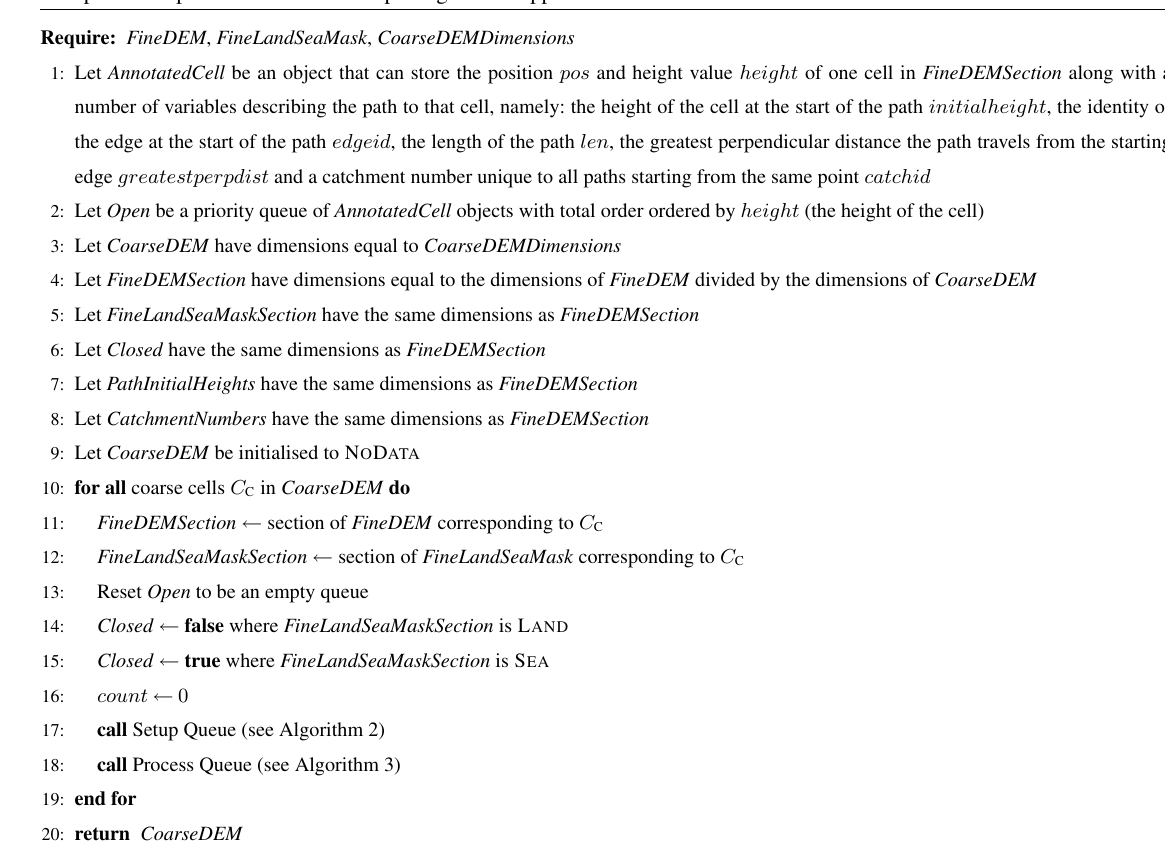
Algorithm 1 Orography upscaling algorithm